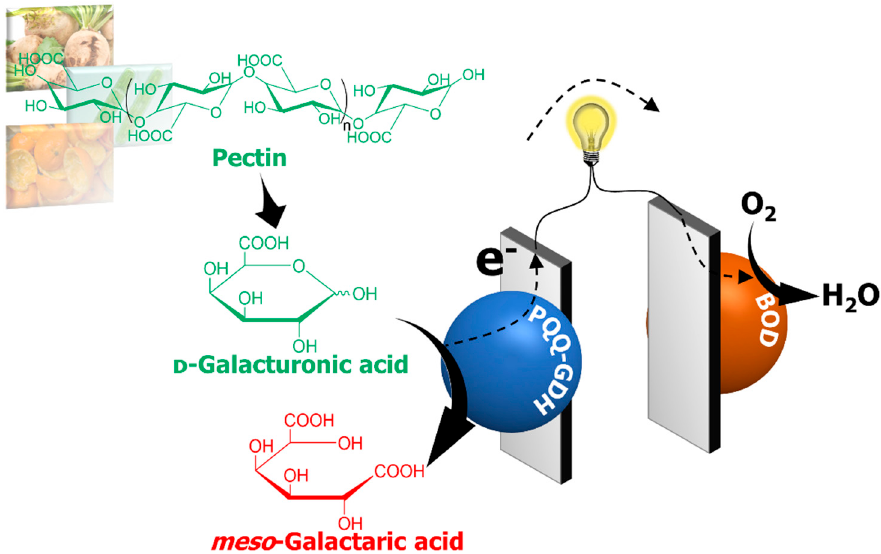
Figure 10. Schematic description of an enzymatic biofuel cell that simultaneously produces meso -galactaric acid and electricity from pectin extracted from biomass. PQQ-GHD = pyrroloquinoline quinone-dependent glucose dehydrogenase; BOD = bilirubin oxidase.